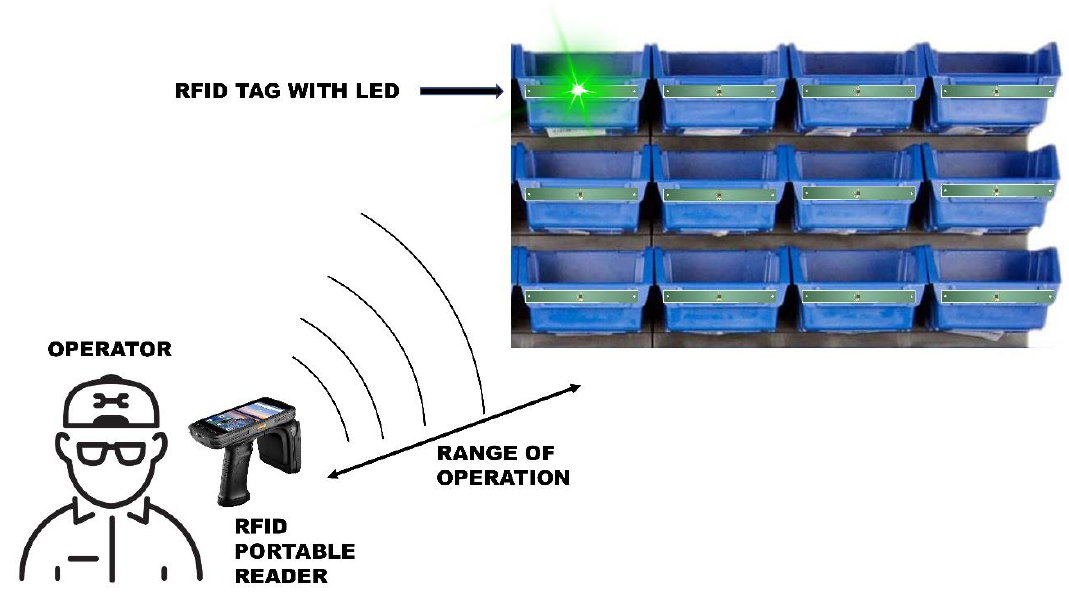
Figure 1. Example of an Ultra High Frequency (UHF) RFID-based “pick to light” system.